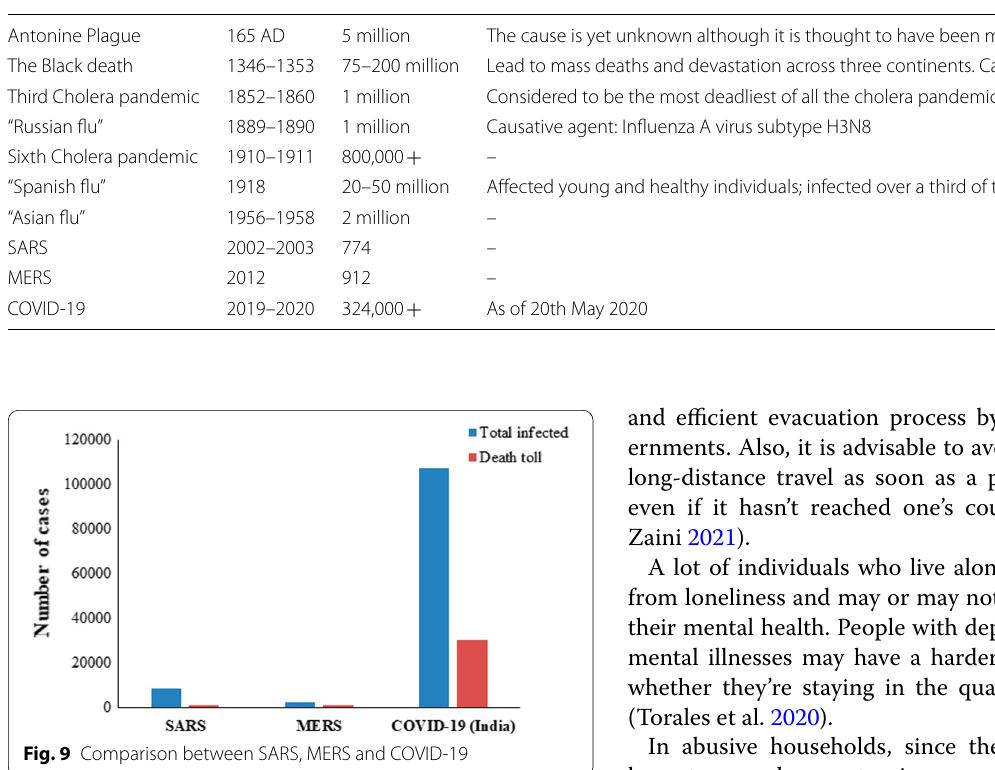
Table 3 Comparison of estimated death tolls of pandemics (the numbers may vary from site to site). Sources Pandemic